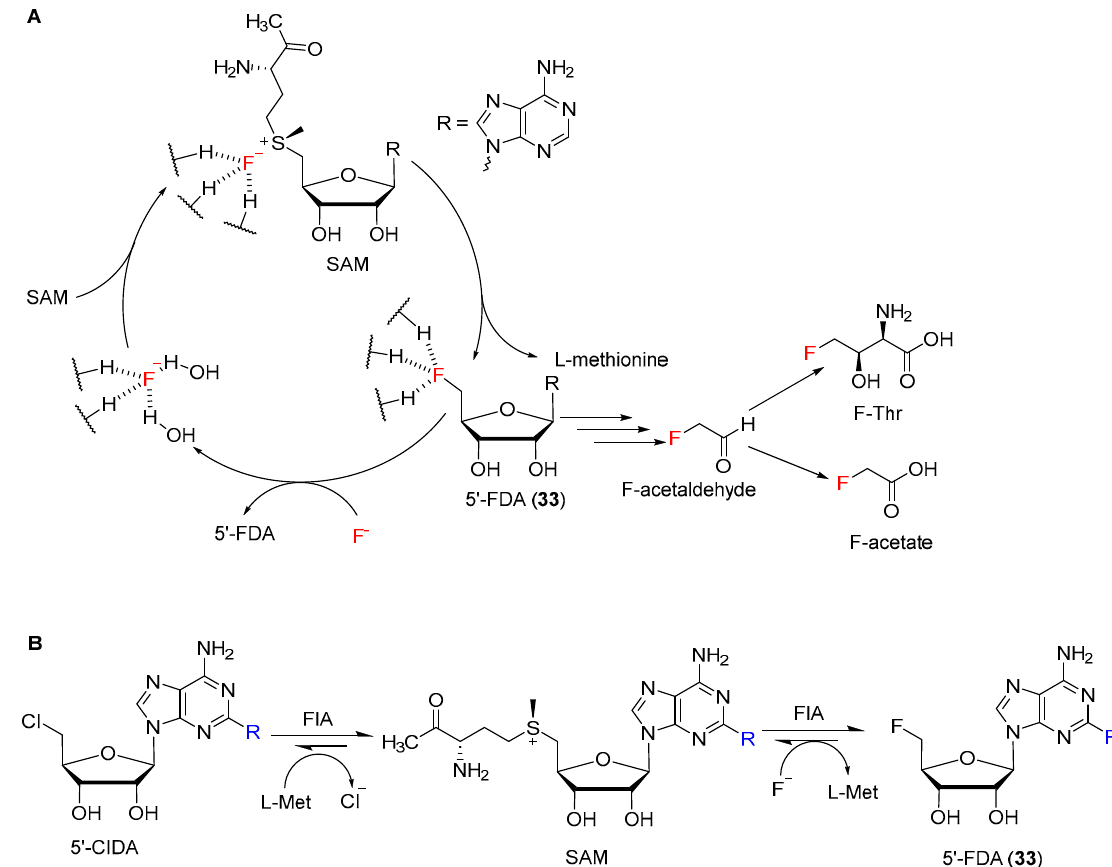
Figure 18. ( A ) Schematically sequential mechanism for the F–C bond formation catalysed by the fluorinase from S. cattleya and some products of subsequently cascade reaction. Dashed lines represents hydrogen bonding contacts with amino acids in the active pocket or water. ( B ) Reaction scheme of fluorinase-mediated trans-halogenation. Rest R marks position of usual derivation. Table 5. Examples for heterologously expressed fluorinase. Kinetic data representing the conversion of 5 ′ -ClDA into S -adenosylmethionine (SAM). Enzyme Origin/Expression Host and Yield Kinetic Parameters Special Substrate Scope